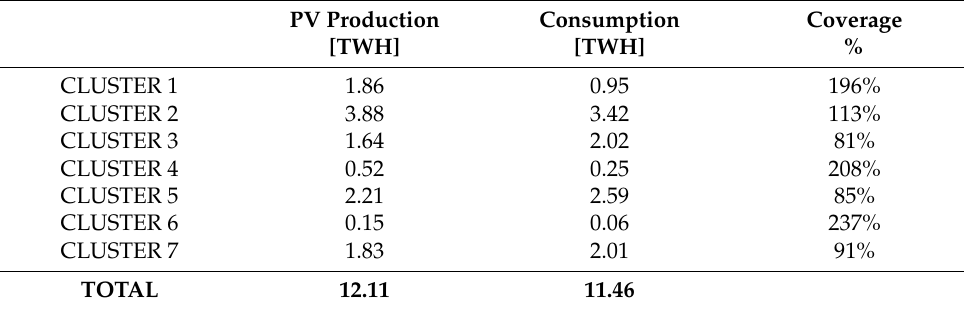
Table 3. Energy balance of the residential sector at the cluster level.